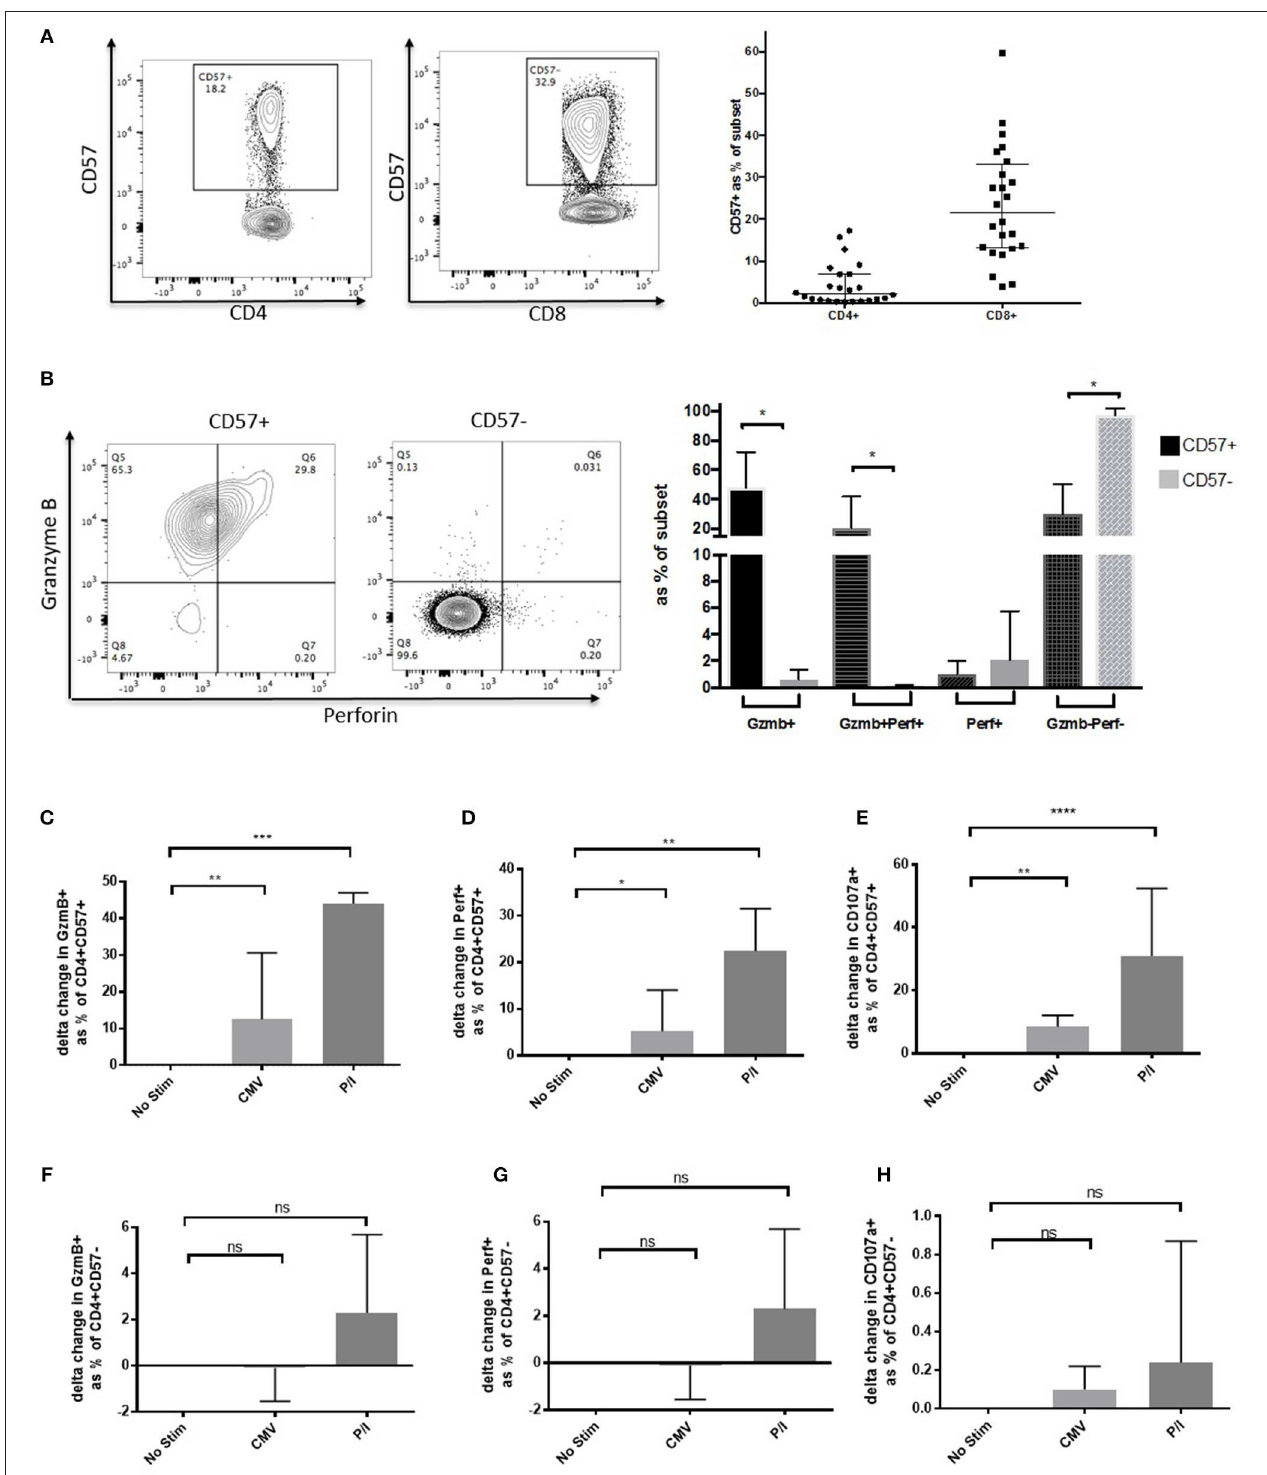
FIGURE 1 | CD57 identifies Cytolytic CD4 + T cells. (A) Representative dot plot showing CD57 expression on CD4 + and CD8 + T cells. Distribution of CD57 levels in healthy donors ( n = 24). (B) Dot plot and column graph showing Granzyme B and Perforin expression in CD57 + and CD57 − CD4 + subsets in healthy donors. (C) Upregulation of Granzyme (B,D) Perforin and (E) CD107a after 6h of activation with CMV and PMA/ionomycin in the CD4 + CD57 + subset ( n = 6). (F–H) Expression of cytolytic markers in CD4 + CD57 − subset 6h post activation ( F = Granzyme B, G = Perforin, and H = CD107a). * p < 0.05, ** p < 0.01, *** p < 0.001, **** p < 0.0001.